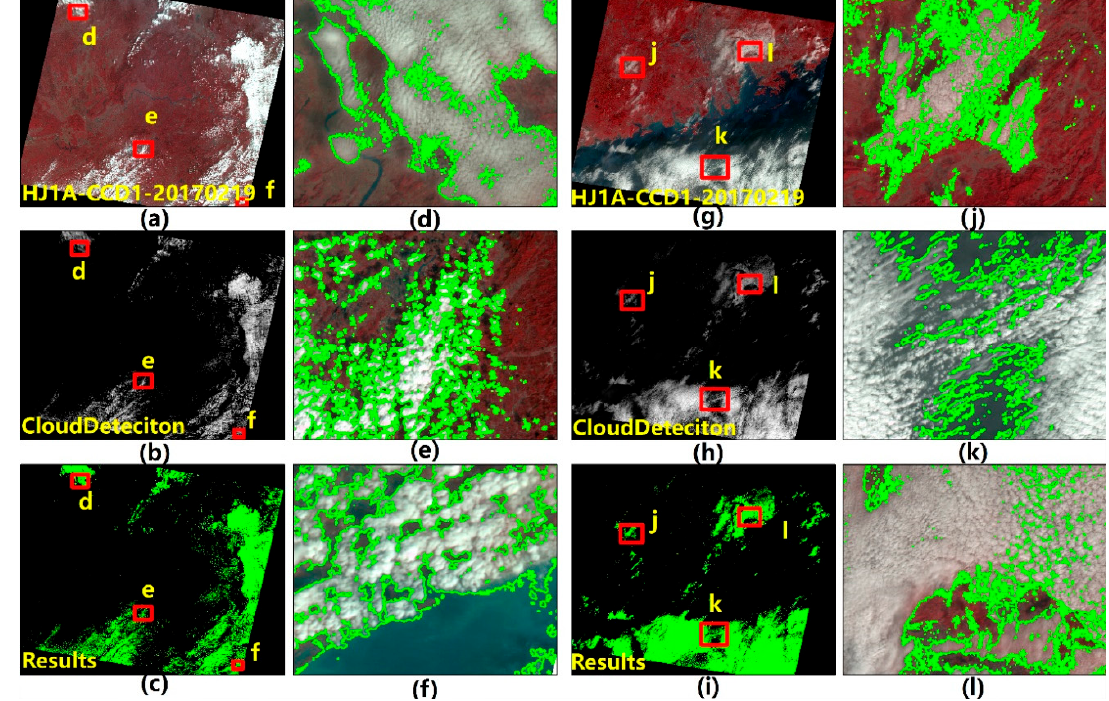
Figure 9. The original map ( a , g ) and the cloud detection results ( b , c , h , i ) obtained using the EN-Clustering method, for two selected HJ-CDD images. ( a ) CCD1 data of HJ-1A acquired on 19 February 19 2017. ( g ) CCD data acquired on 10 December 2016; ( d – f ) present the magnified versions of the original data ( a ), while ( j – l ) present the magnified versions of the original data ( g ). Data acquisition location for all these data was the northern coastal zone of the